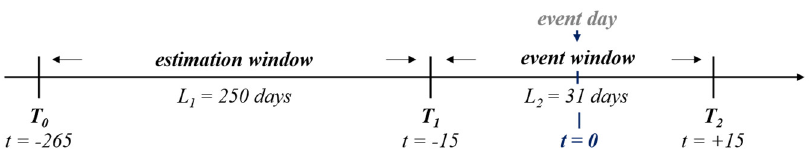
Figure 1. Timeline for the event